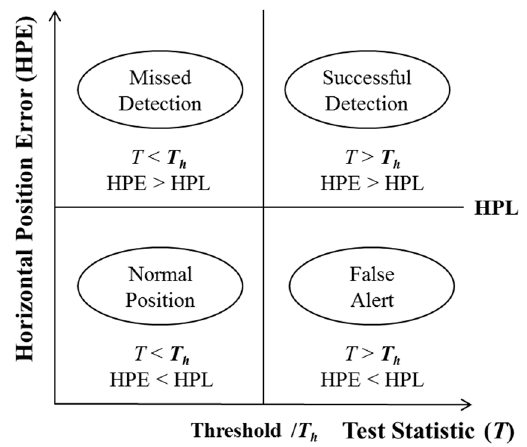
Figure 3. Conditions in FaultDetection.